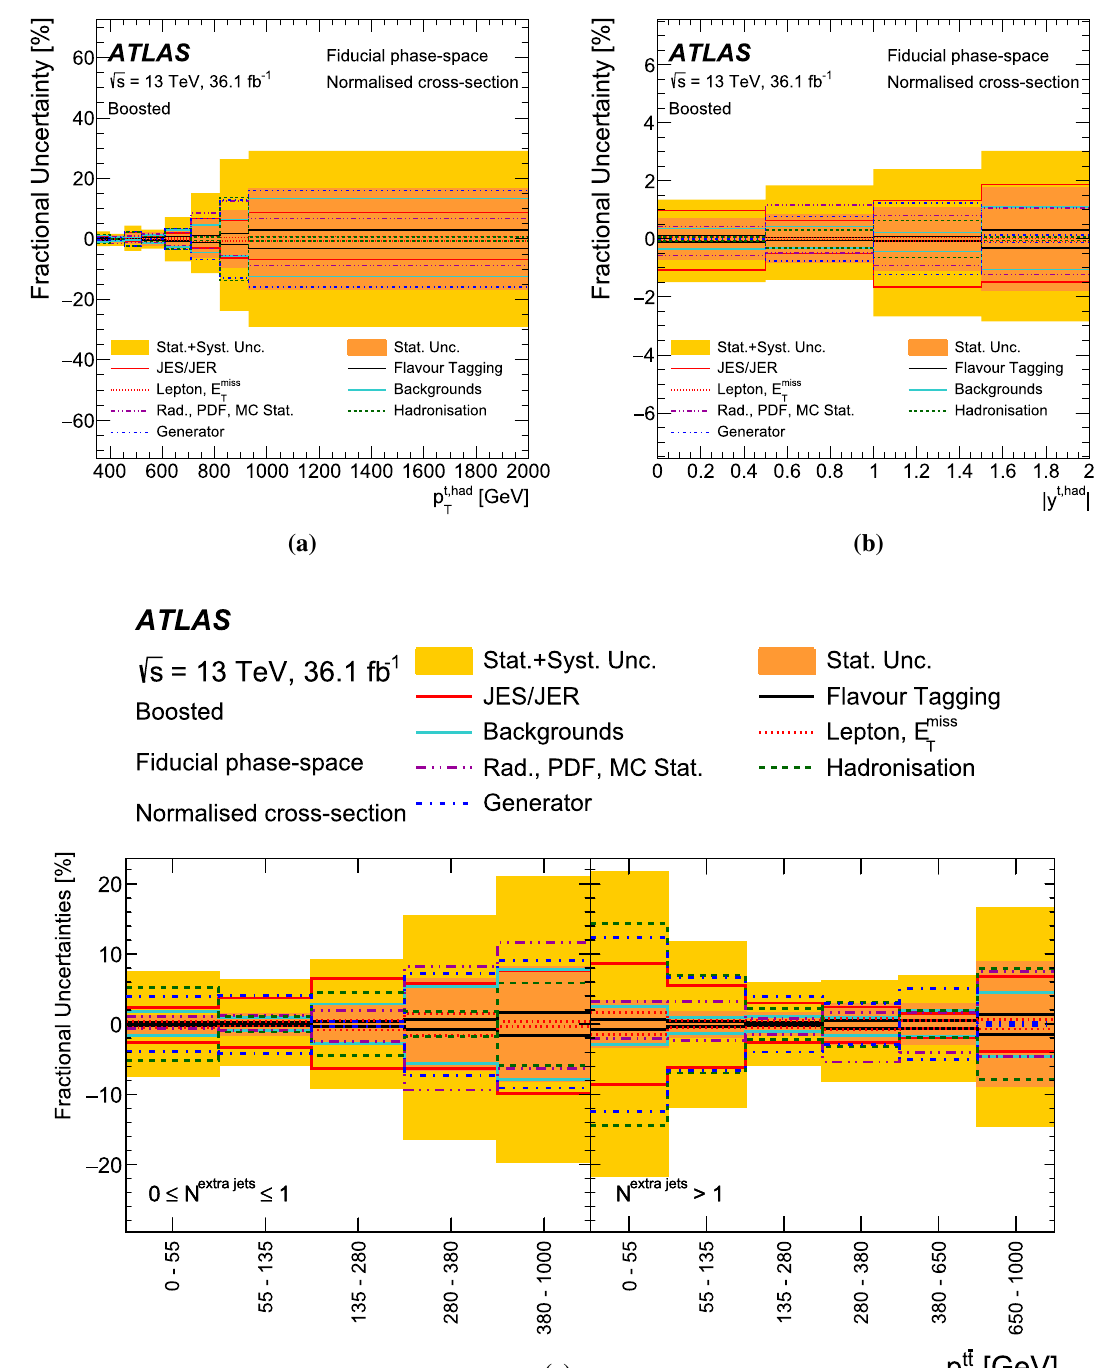
Fig. 19 Uncertainties in the particle-level normalised differential cross-sections as a function of a the transverse momentum, b the rapid- ity of the hadronically decaying top quark and c the p T of the t ¯ t system